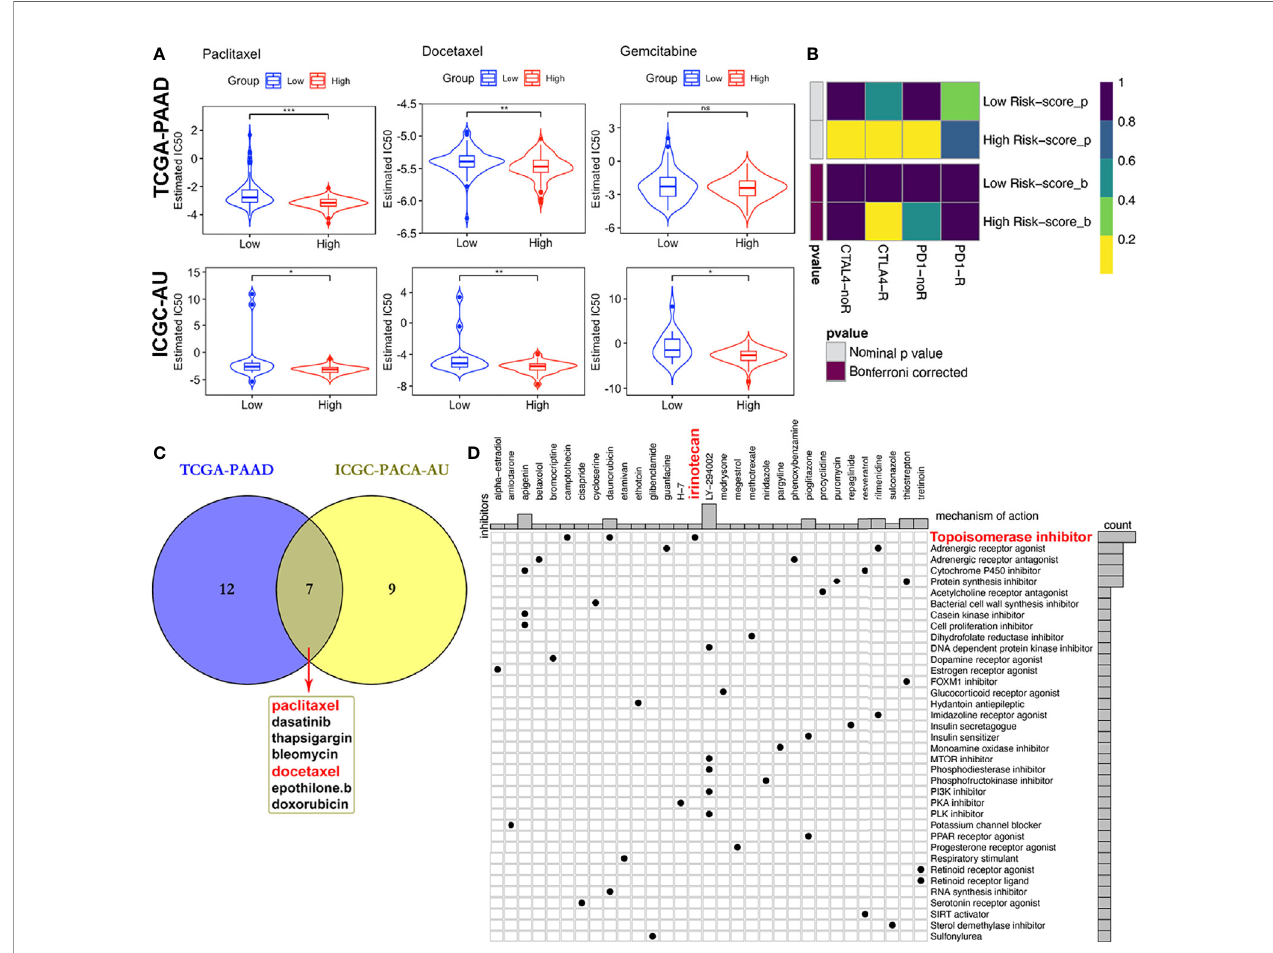
FIGURE 10 | Differential putative therapeutic responses. (A) Boxplots showing estimated IC50 values for docetaxel, paclitaxel and gemcitabine in the TCGA-PAAD and ICGC-PACA-AU datasets. (B) Submap analysis revealed that patients with high scores might be more sensitive to CTLA-4 blockade therapy (Bonferroni- corrected P = 0.02). (C) Venn plot of candidate chemo and targeted drugs identi fi ed by the GDSC database in TCGA and ICGC-AU datasets. (D) CMap database analysis identi fi ed potential compounds targeting the four-MDG signature. (*p<0.05, **p<0.01, ***p<0.001, ns, non-signi fi